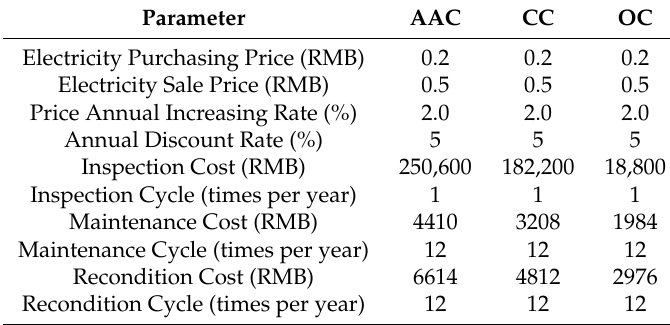
Table 8. Operation and maintenance parameters in Case 2.